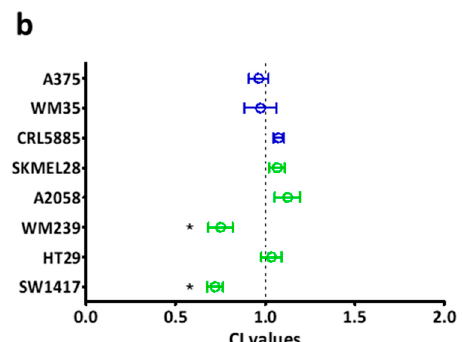
Figure 3. Combinatory effect of selumetinib + BEZ235 on the cell lines for 10 days. ( a ) Combination index (CI) was calculated from long term (10 days) clonogenic assay results upon treatment with a combination of selumetinib and BEZ235 in different concentrations. CI < 1, CI ≈ 1, and CI > 1 mean synergistic, additive, and antagonistic effect, respectively. In most of the cell lines, the combination treatments were closely additive except for WM239 and SW1417, where synergy was detected. Data is from at least three independent experiments. ( b ) The average CI values of the cells. Data is shown as mean ± SEM from at least three independent experiments. Combination index in WM239 and SW1417 cell lines was significantly lower than 1. Asterisks mean a significant difference between CI ≈ 1 and the given CI value of the cell by * p < 0.05.